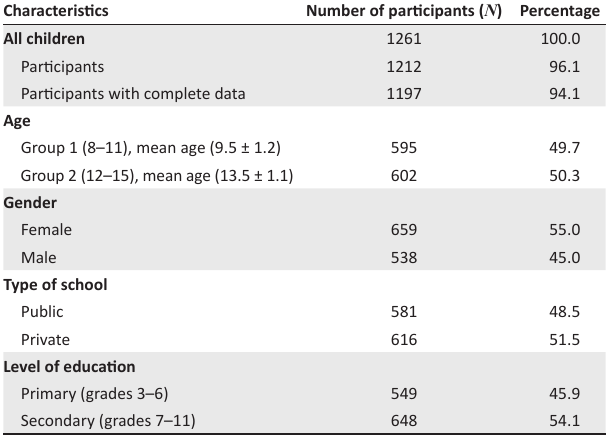
TABLE 2: Prevalence of myopia by age group, gender, level of education and type of school.